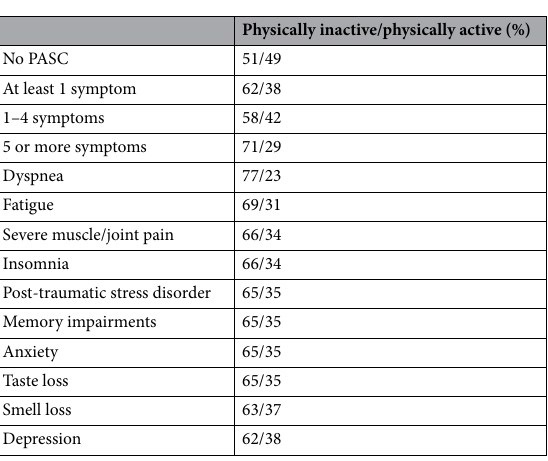
Table 3. Relative frequency of physically inactive and active individuals (> 150 min/week) according to the presence of post-acute sequelae of SARS-CoV-2 evaluated 6–11 months following hospitalization. PASC Post- acute sequelae of SARS-CoV-2